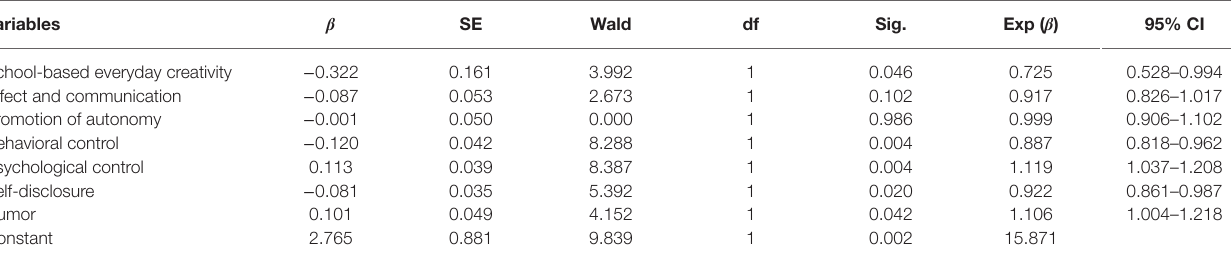
TABLE 3 | Results derived from the logistic regression for the probability of failing a subject, by school-based everyday creativity and parenting style. Variables β SE Wald df